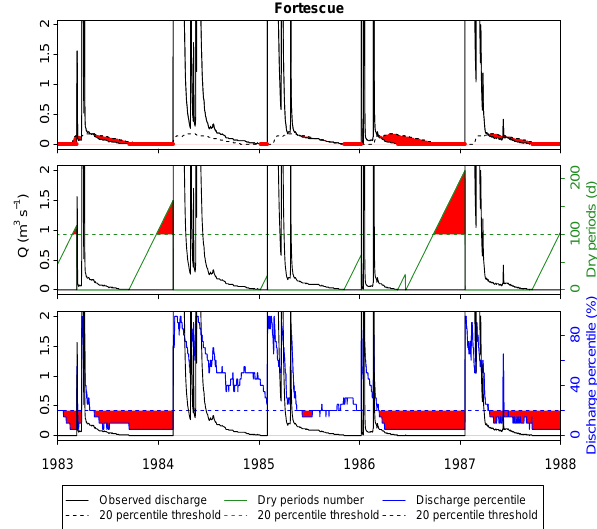
Fig. A4. Drought events (indicated in red) identified by the different methods for the Fortescue River. The upper panel gives the TLM. Discharge values are shown as solid black line; the dashed line is the calculated threshold (20th percentile). The middle panel gives drought events calculated with the CDPM. The consecutive dry pe- riods are indicated by the green line, and droughts are identified if periods exceed the threshold (dashed green line). When combining these methods, the discharge is converted to percentile values (low- est panel, blue solid line). If the percentile value drops below or equals the 20% (dashed blue) line, the month is in